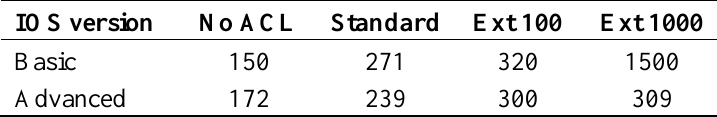
Table 2. Average delays for all tests (times in µs).